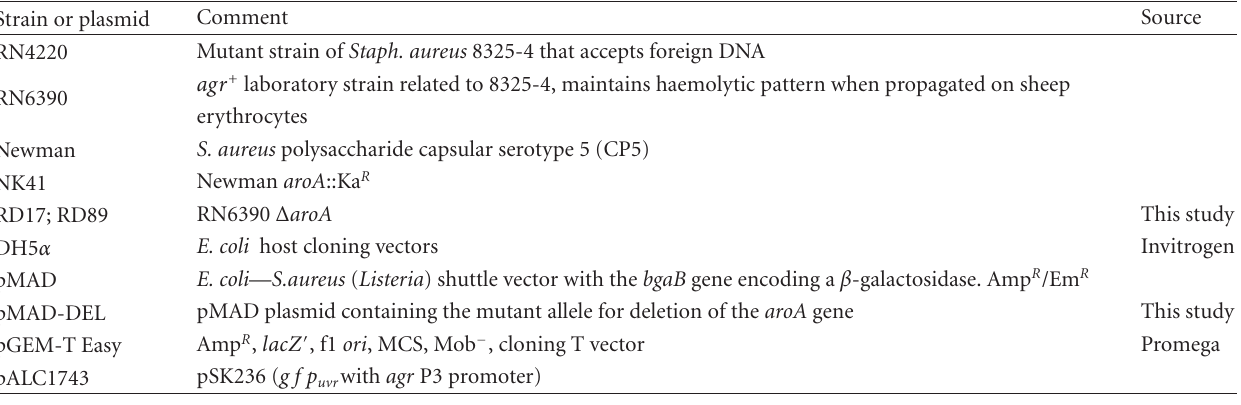
Table 1: Bacterial strains and plasmids used in this study.